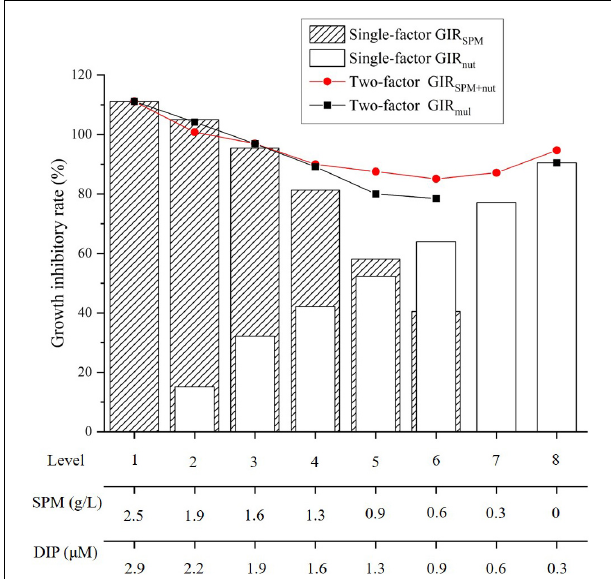
FIGURE 7 | Growth inhibitory rate in the single-factor nutrient experiment (GIR nut ), single-factor SPM experiment (GIR SPM ), and two-factor experiment (GIR SPM + nut ). The black dots represent the GIR predicted from the multiplicative effect of SPM and nutrient (GIR mul